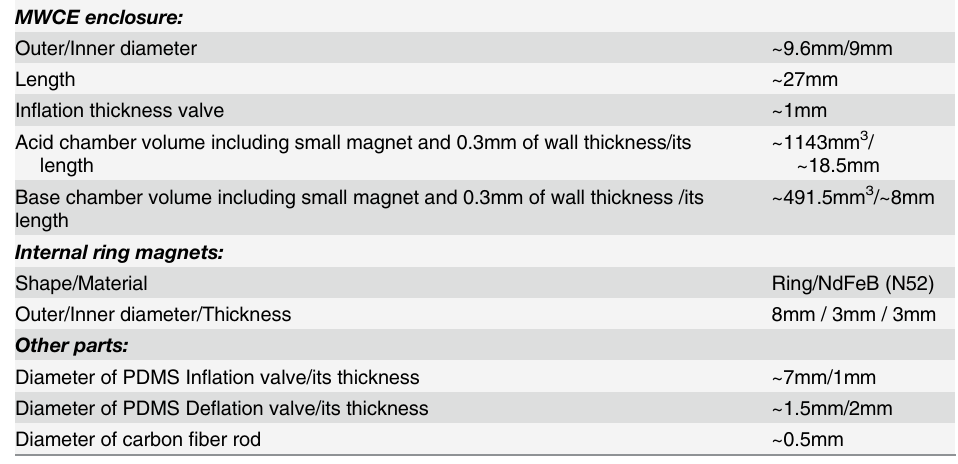
Table 2. Specification of the MWCE